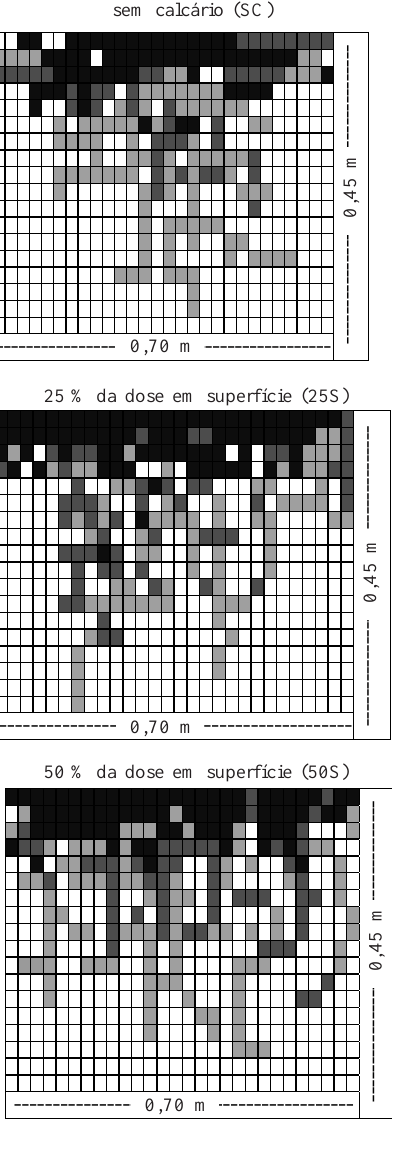
Figura 6. Perfil de enraizamento da cultura do milho aos 54 dias da emergência no Argissolo Vermelho distrófico arênico sob semeadura Mg 2+ no solo. O tratamento SC apresentou menor quantidade de raízes no perfil estudado.